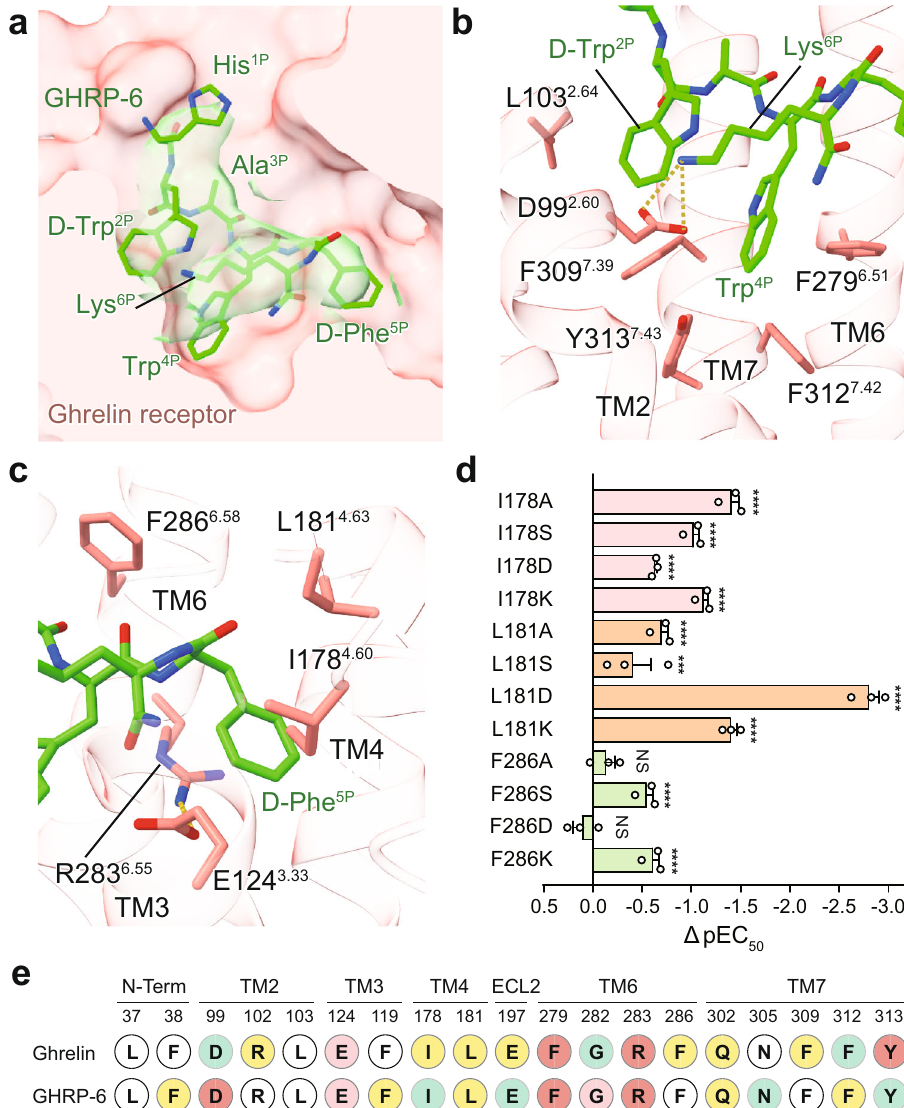
Fig. 3 The GHRP-6-binding pocket of ghrelin receptor. a Cross-section of the GHRP-6-binding pocket in ghrelin receptor. The cryo-EM density of GHRP-6 is highlighted. GHRP-6 is shown in a cartoon presentation. Side chains of the residues are displayed as sticks. b , c Detailed interactions of GHRP-6 with residues in GHRP-6 binding pocket. The binding site of D-Trp 2P , Trp 4P , Lys 6P ( b ) and D-Phe 5P ( c ) are shown. The hydrogen bond is depicted as a yellow dashed line. GHRP-6 is shown in green, and ghrelin receptor in salmon. d Effects of mutations of residues in D-Phe 5P binding pocket on calcium response. Δ pEC50 represents the difference between pEC 50 values of the mutant ghrelin receptor and the wild-type (WT) receptor. Data are presented as mean ± S.E.M. of three independent experiments performed in technical triplicate. *** P < 0.001, **** P < 0.0001 vs. WT receptor, NS, no signi fi cant difference. All data were analyzed by two-side, one-way ANOVA with Tukey ’ s test ( P < 0.0001, P < 0.0001, P < 0.0001, P < 0.0001, P < 0.0001, P = 0.0009, P < 0.0001, P < 0.0001, P = 0.6335, P < 0.0001, P = 0.8310, and P < 0.0001 from top to bottom). e Interaction residues in the ligand-binding pocket of the ghrelin – ghrelin receptor – G q and the GHRP-6 – ghrelin receptor – G q complexes. Compared with WT receptor, the alanine replacement of residues showed comparable impacts on peptide ’ s activity are indicated by white circles. The alanine mutation of residues showed 2-10-fold, 10-100-fold, 100-1000-fold, and over 1000-fold decreased peptide ’ s activity are indicated by yellow, green, pink, and salmon circles,